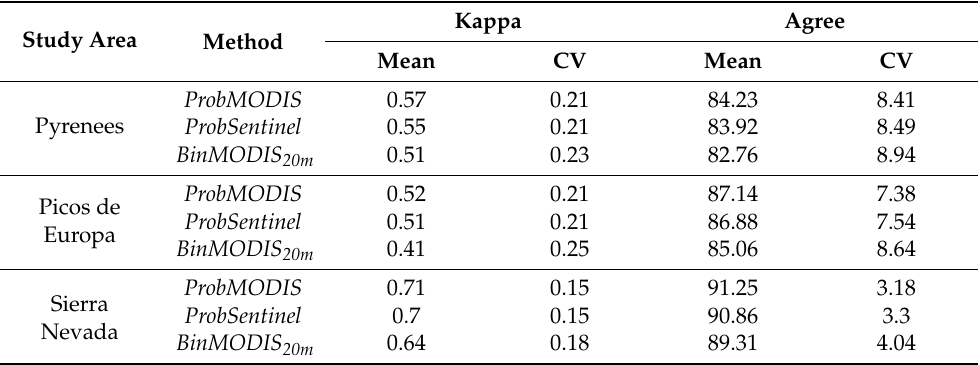
Table 2. Mean values and standard deviations of the error estimates for the three study